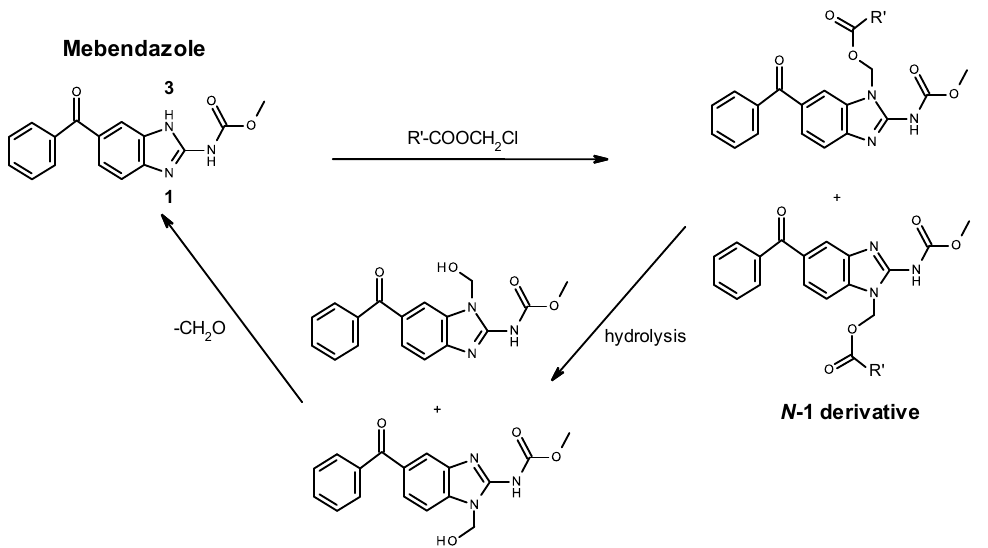
Figure 3. Generation and cleavage of the MBZ derivative. (R’ represents the linker connected to the polymer.) A statistical mixture of N -1 and N -3 derivatives is formed due to the tautomerism of the MBZ molecule (1,3-H shift).